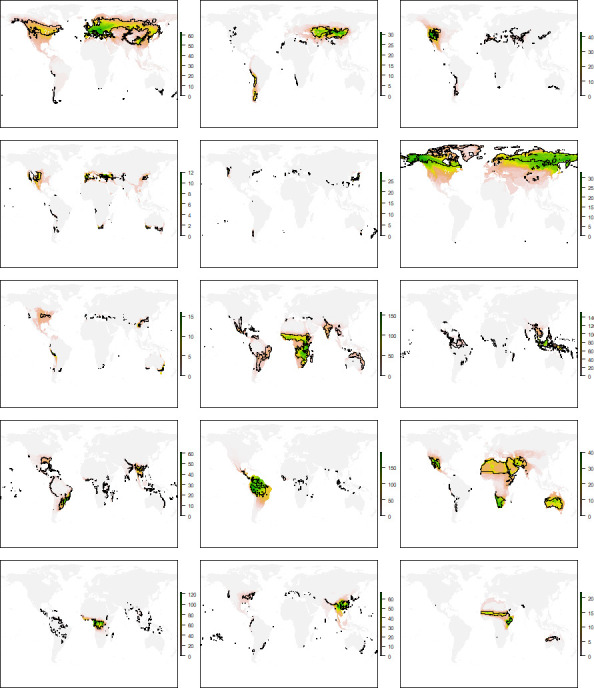
Distribution of the climatic conditions (black line) and the species (colored richness values) belonging to the same niche domains of mammals.